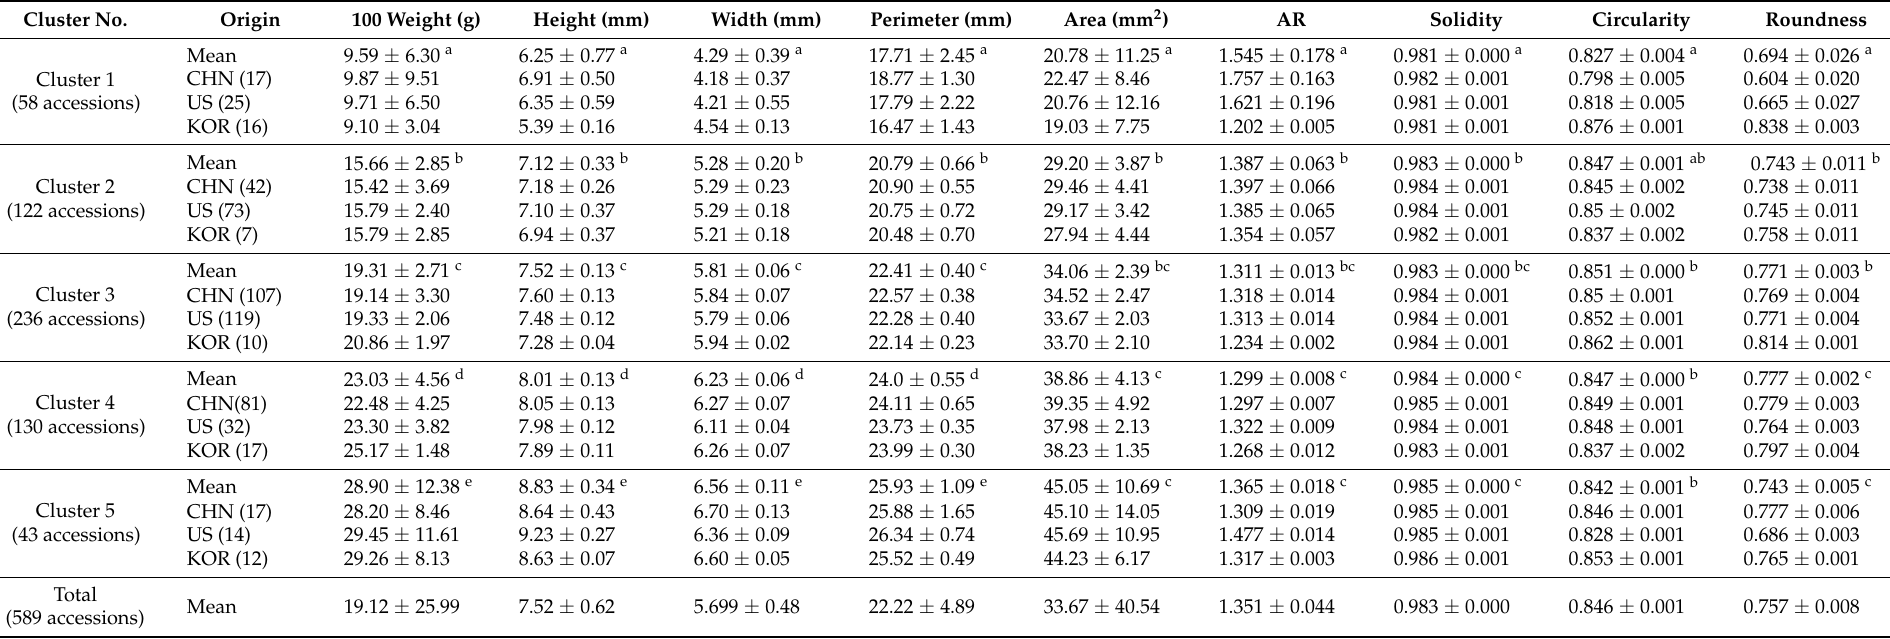
Table 2. Comparison of 9 seed morphological traits between groups divided into 5 clusters using k-means clustering and origin within clusters. Cluster No. Solidity Circularity